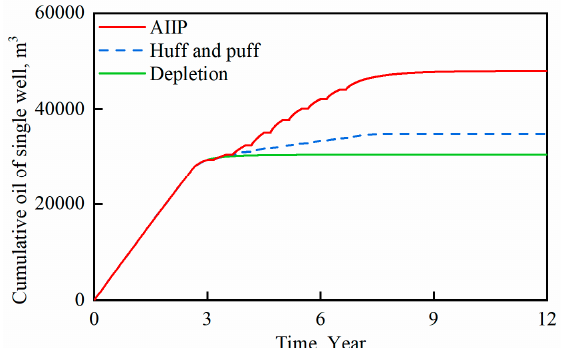
ff erent development modes. Energies 2019 , 12 , x FOR PEER REVIEW